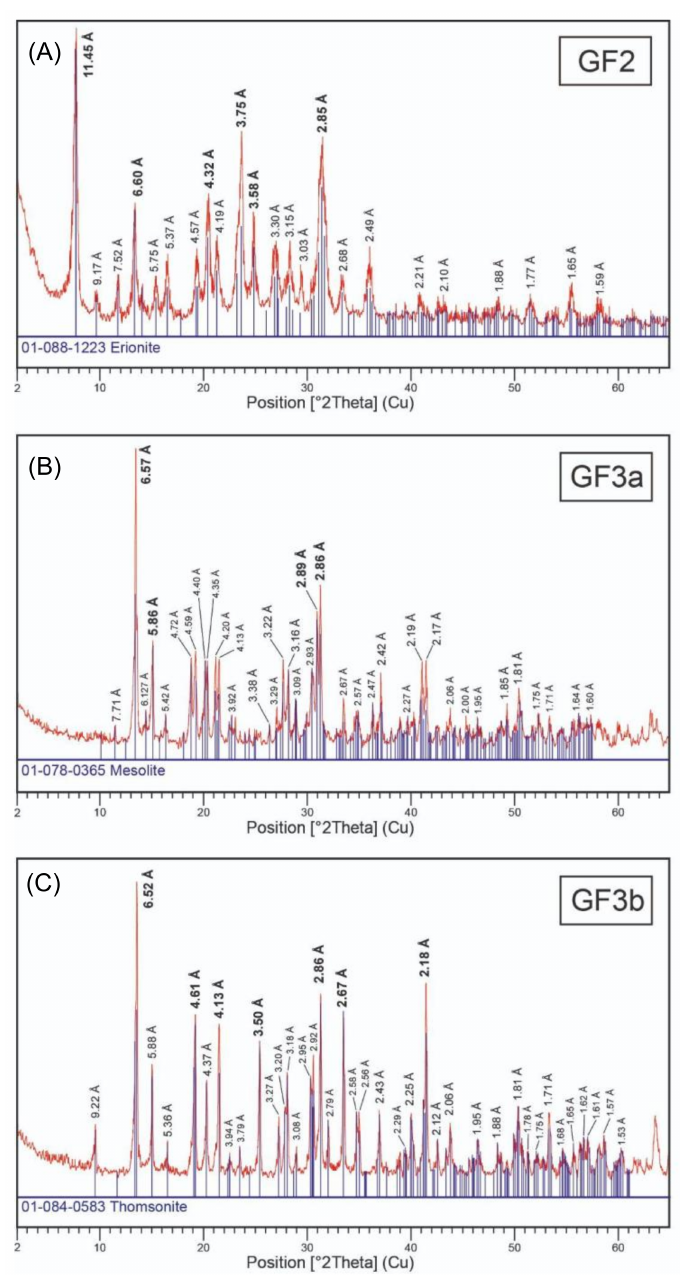
Figure 2. XRPD patterns of the investigated samples. The main diagnostic peaks are in bold. ( A ) erionite GF2, ( B ) mesolite GF3a, and ( C ) thomsonite